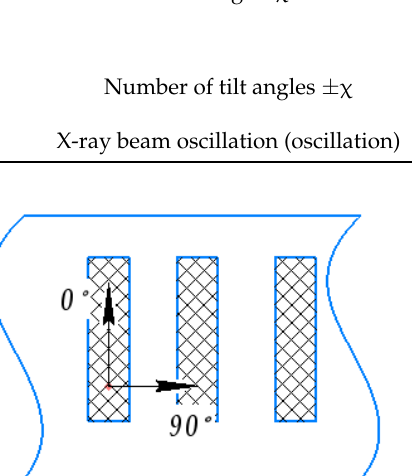
Table 5. Parameters of mathematical processing of OH measurement results.